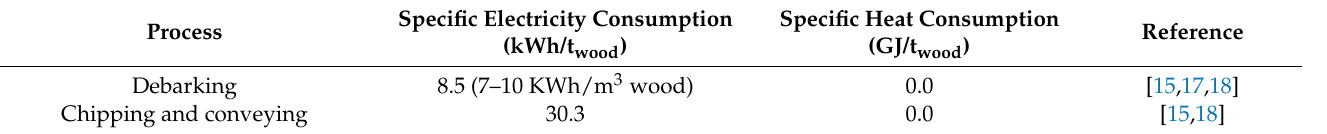
Table 1. Specific electricity and heat consumption of the wood processes in pulp and paper production. Specific Electricity Consumption Specific Heat Consumption Reference Process (kWh/t wood ) (GJ/t wood ) Debarking 8.5 (7–10 KWh/m 3 wood) 0.0 Chipping and conveying